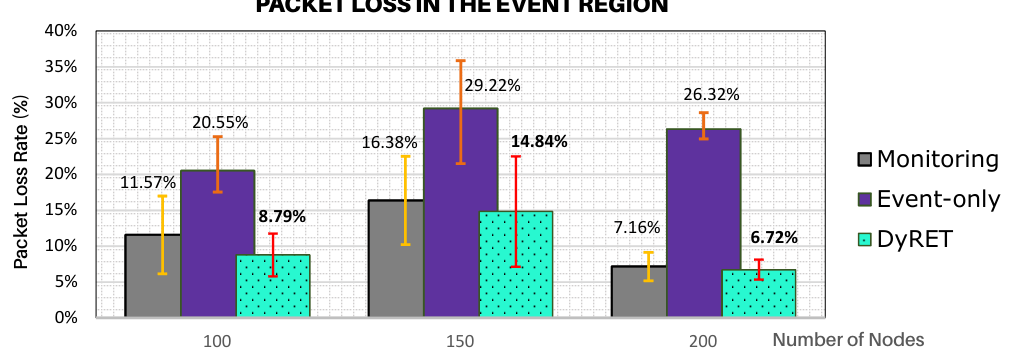
Figure 12. Average packet loss rate for sensor nodes involved in the critical event, considering all simulation scenarios.